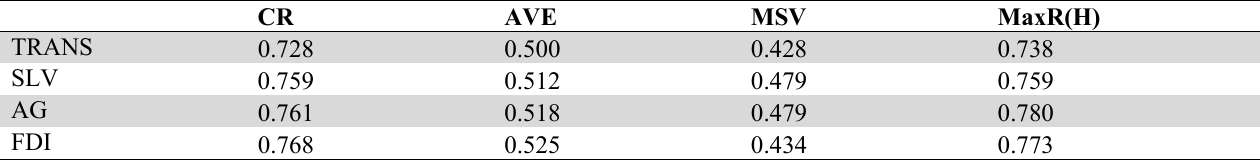
Convergent and Discriminant findings